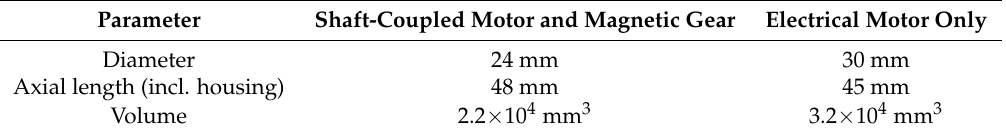
Table 6. Comparison between outer dimensions and volume of the shaft-coupled motor and magnetic gear, and an electrical